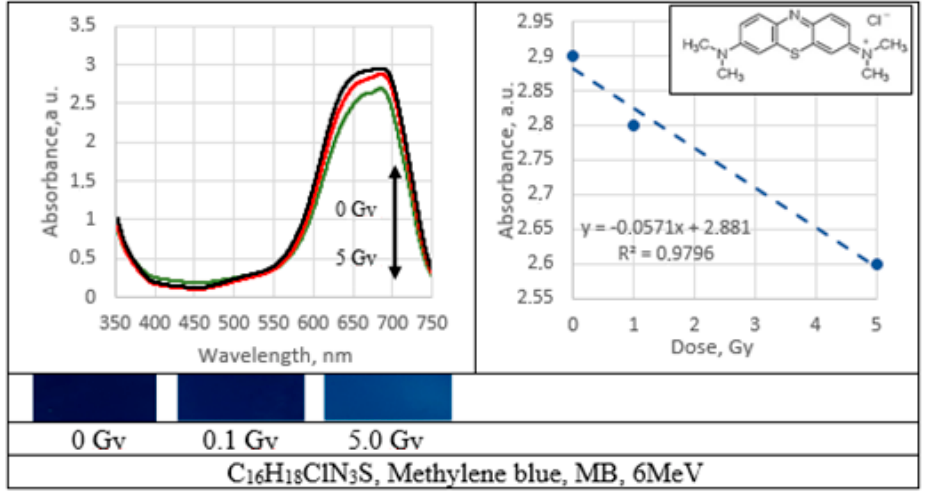
Figure 5. Absorbance spectra and sensitivity of the irradiated methylene blue films.